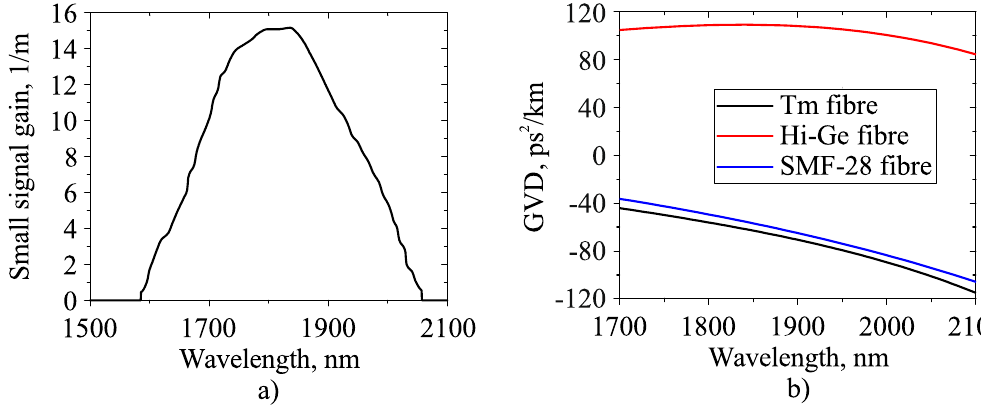
Figure 2. ( a ) Small signal gain of the active Tm-doped fibre; ( b ) group velocity dispersion (GVD) of cavity